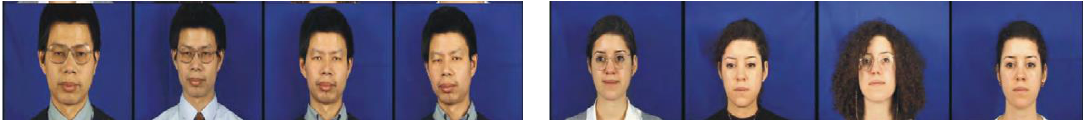
Figure 8. Examples of XM2VTS (multi modal verification for teleservices and security applications) facial images of the same subject under different periods.